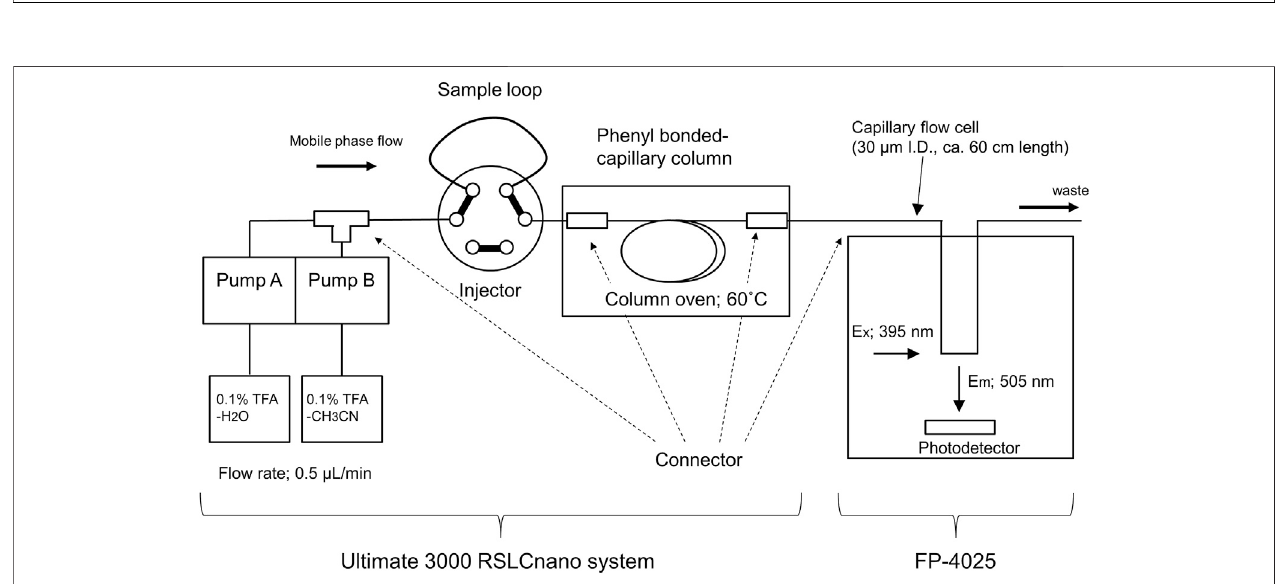
FIGURE 4 | Chromatograms corresponding to 8.0 µg of total protein obtained from six human colorectal cancer cell lines and a normal colorectal cell line after derivatization withDAABD-Cl. The peaks indicated byblack arrows (1 – 14) differed in intensity between thecancer celllinesand thenormal cell line. The peaks indicated by red arrows (a – l) differed in intensity between the metastatic cell lines and the non-metastatic cell line.